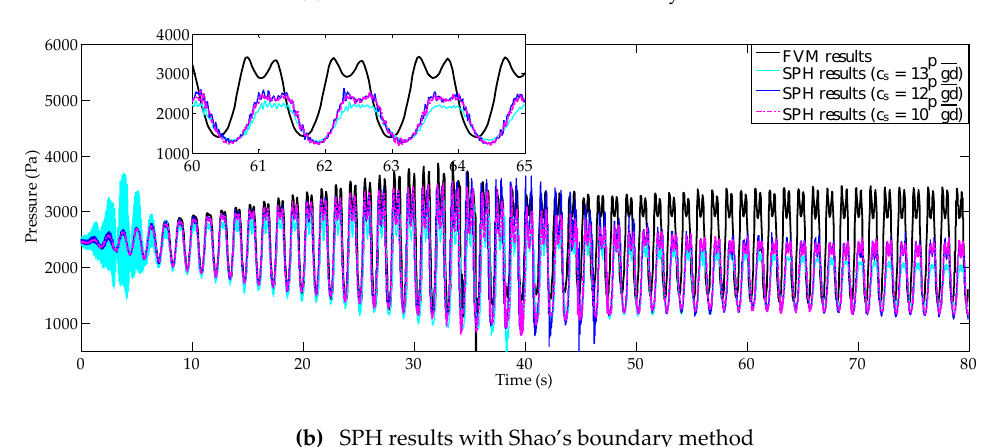
FVM results SPH results (c s = SPH results (c s = SPH results (c s =